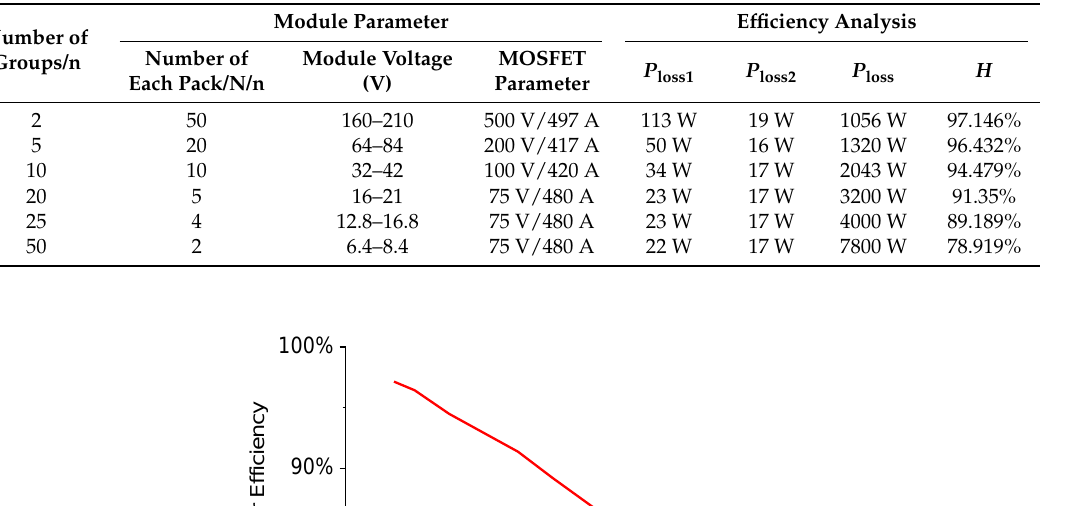
Table 3. Converter efficiency calculation.